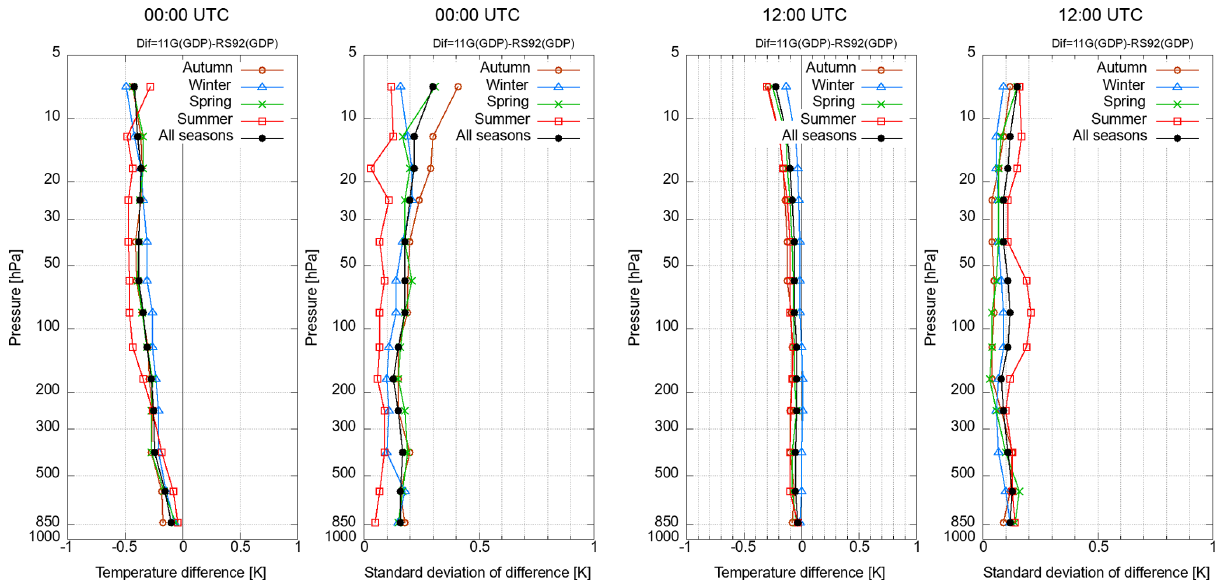
Figure 10. Profiles of mean temperature differences (RS-11G GDP minus RS92 GDP) and standard deviations for each season and for all seasons combined. Brown, blue, green, and red lines show means for autumn, winter, spring, and summer, respectively, and black lines show means for all seasons.